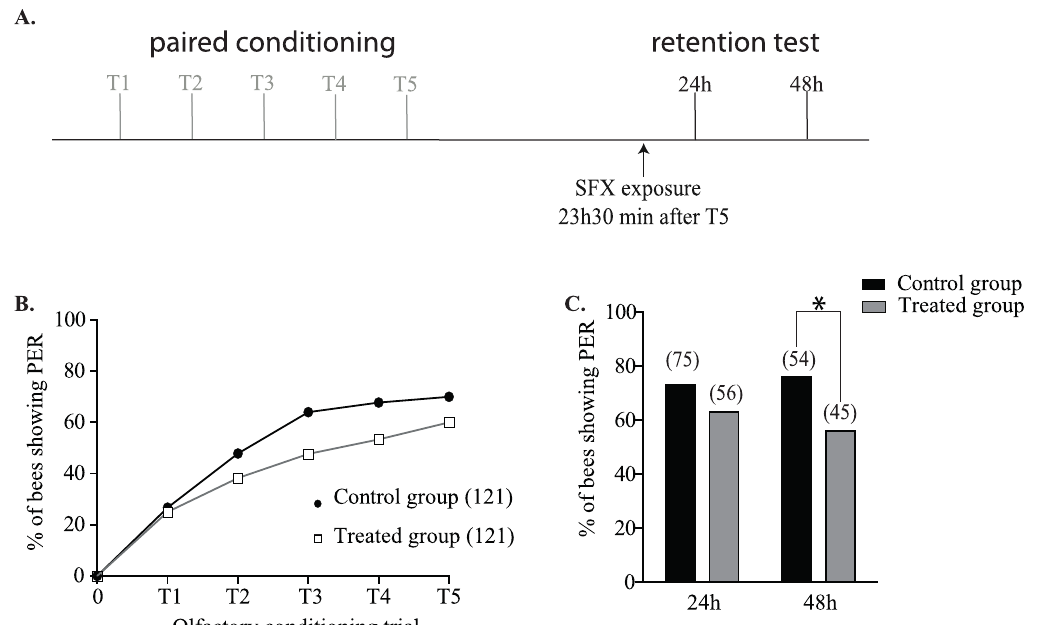
Fig 6. Effect of sulfoxaflor sublethal dose on memory processes after exposure 23h30 after conditioning. A . Experimental procedure used in protocol 4: 23h30 after the last olfactory conditioning trial (T5), treated and control bees received 2 μ L of SFX solution (15 ng/bee) or 50% (w/v) sucrose solution respectively. B . The response (PER or no PER) of each bee was registered during each conditioning trial. Only surviving bees showing a proboscis extension response at the end of the olfactory conditioning were considered for the restitution test. C . The restitution tests were carried out 24 h and 48 h after the last olfactory conditioning trial. Asterisks indicate statistically significant differences in the test group response compared to the control group (P < 0.05). The number of individuals in each group is given into